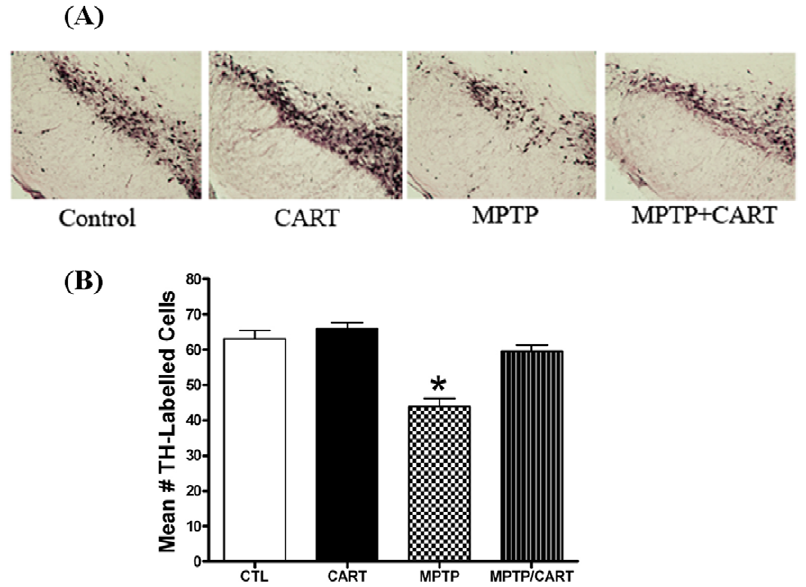
Figure 6. Effect of CART on the number of TH-labeled neuronal cells in the SN-PC. A. ) Example of TH-immunolabeled neurons within the SN-PC in all four groups: CTL: control group (vehicle + vehicle); CART (CART + vehicle); MPTP (vehicle + MPTP); MPTP/CART (CART + MPTP). There is a decrease in the number of TH-labeled cells in the MPTP only group compared to all other groups. Administration of CART reversed the MPTP-induced decrease in TH-labeled cells. B. ) CART peptide (50 ng/mouse, IP) or vehicle (0.1 ml/10 grams, IP) was injected one day prior to the start of sub-acute administration of either MPTP (7 mg/kg/d) or vehicle for 7 days. On days 1–7, CART or vehicle were injected 30 minutes prior to administration of either MPTP or vehicle. On day 8, mice were perfused with fixative and the SN-PC cut and processed for TH immunolabeling. CART pretreatment blocked the MPTP-induced decrease in the number of TH labeled cells/section of the SN-PC. *, p , 0.05 compared to all other groups.